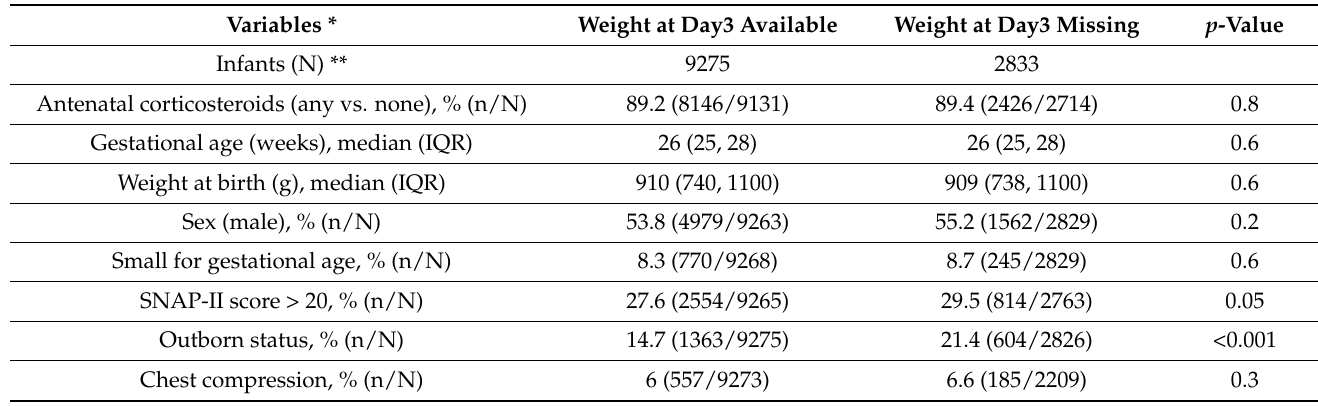
Table 2. Maternal and neonatal characteristics between those with and without missing weight change (% of birth weight) data at day three of age.